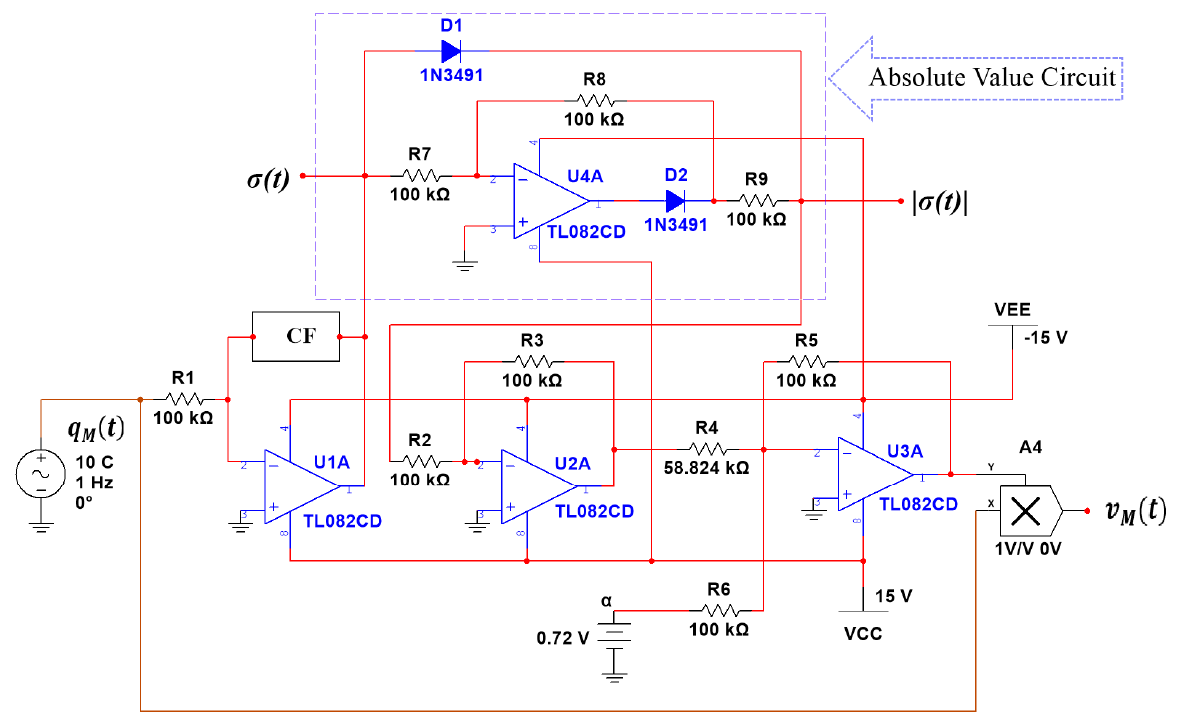
Figure 4. The electronic circuit layout of the fractional-order memcapacitor. By applying a charge with 10 C amplitude, 1 Hz frequency, and 0.99 fractional deriva- tive value of the fractional-order memcapacitor, the q M − v M characteristic curve is obtained, as displayed in Figure 5. The electronic circuit of the fractional-order memcapacitor is realized using Multisim. The figurative scheme of a fractional-order memcapacitor is shown in Figure 6.